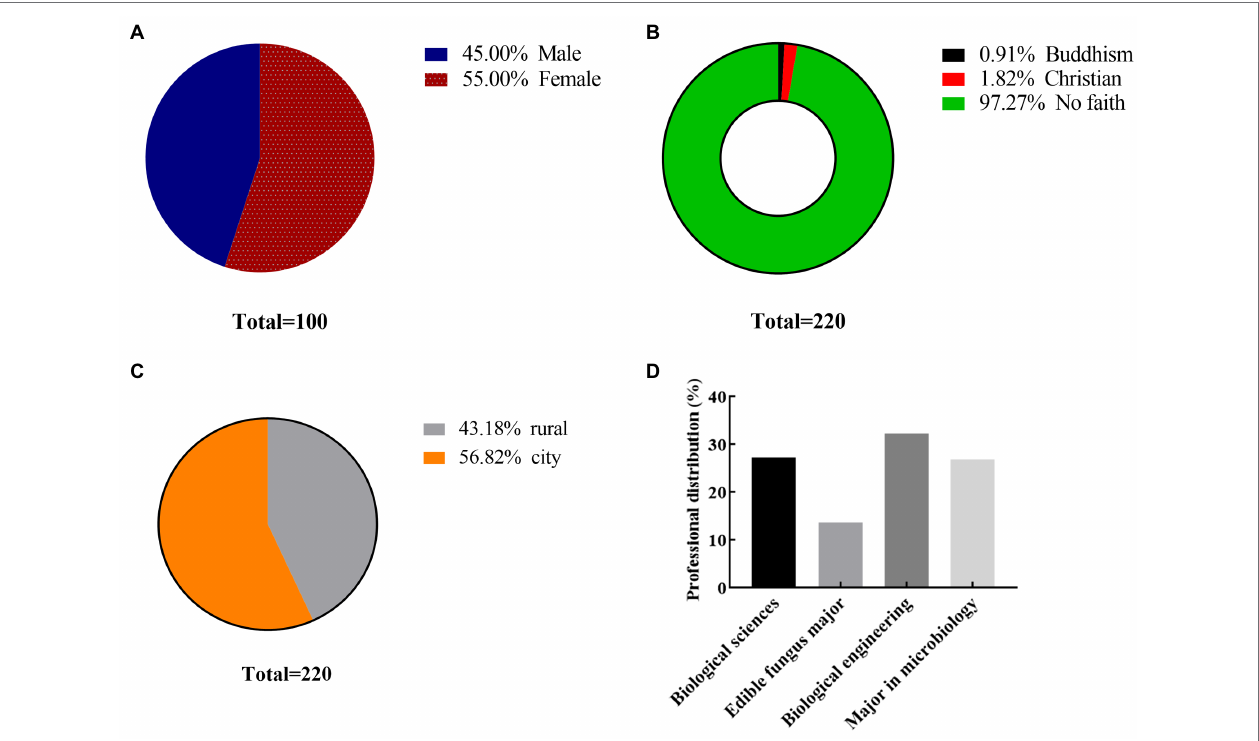
FIGURE 2 | Basic information of the research object. (A) Gender ratio; (B) religious beliefs; (C) family situation; and (D) professional